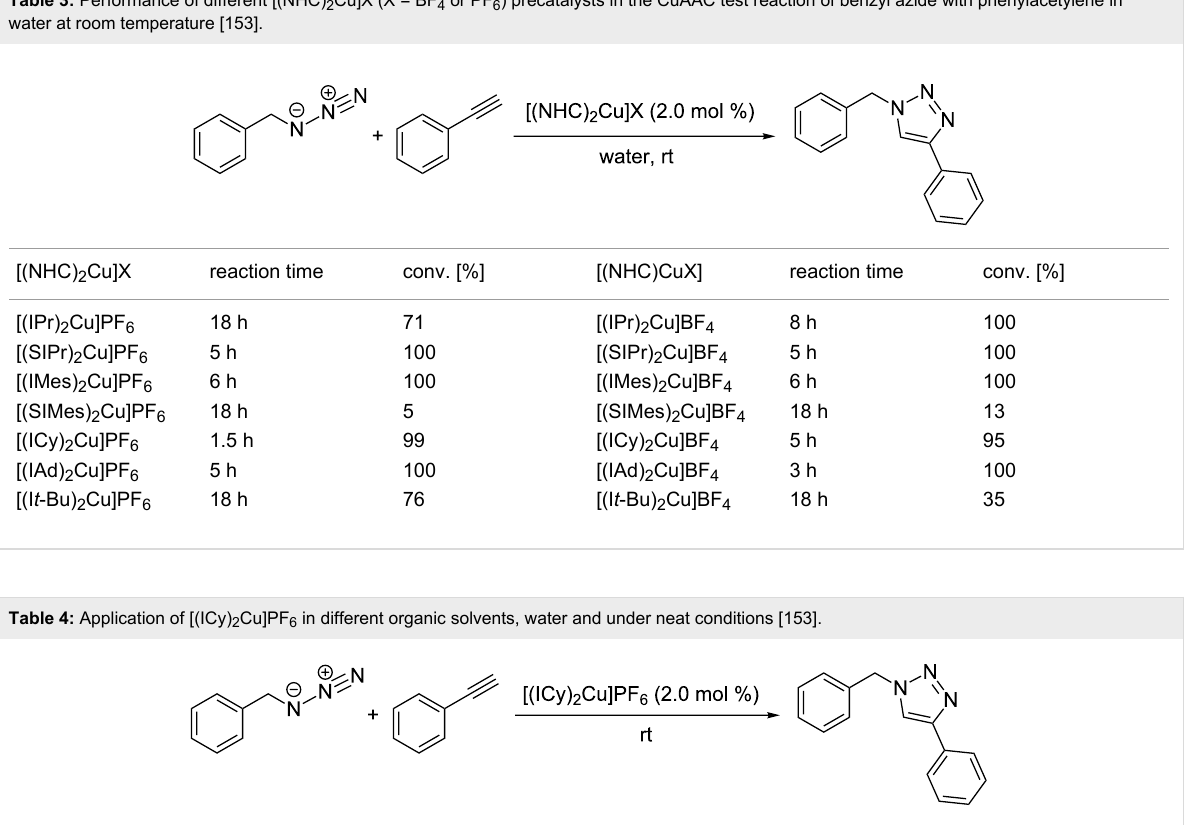
Table 3: Performance of different [(NHC) 2 Cu]X (X = BF 4 or PF 6 ) precatalysts in the CuAAC test reaction of benzyl azide with phenylacetylene in water at room temperature [153].